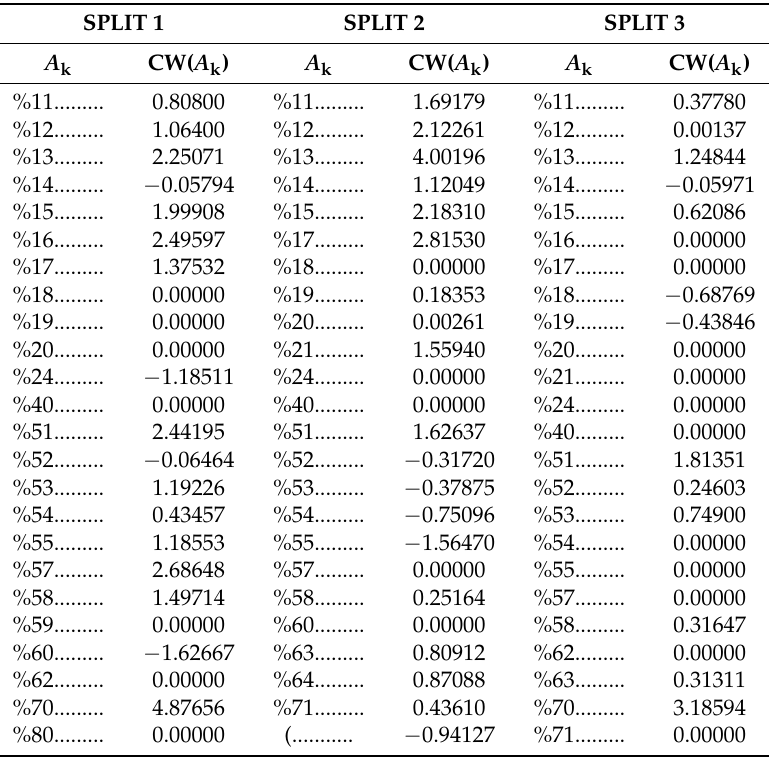
Table 2. Correlation weights of attributes of quasi-SMILES for developed